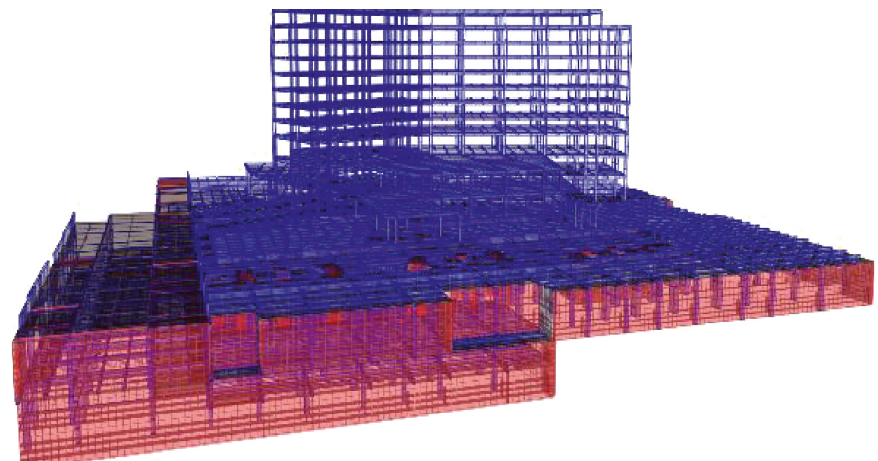
Figure 13: The SAP2000 model of the